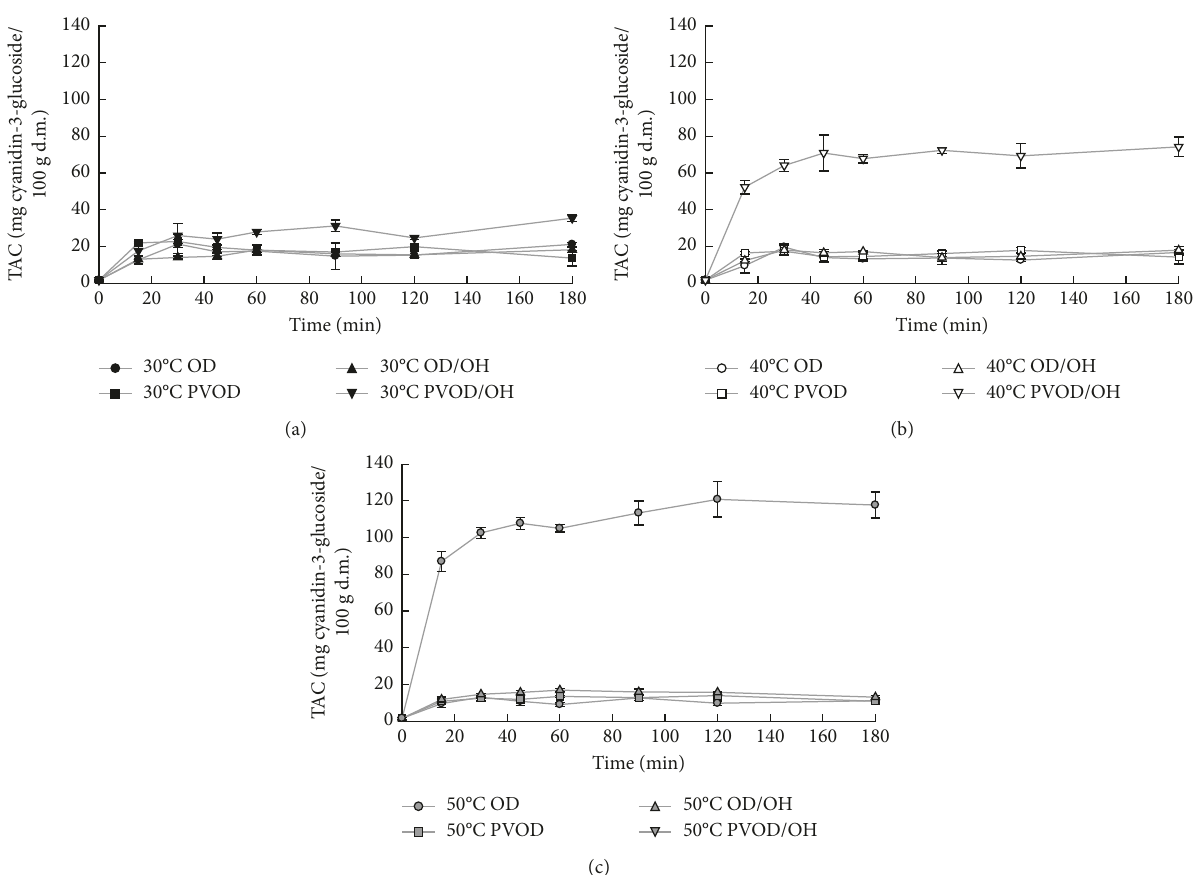
Figure 3: Total anthocyanin content (TAC) kinetics of osmodehydrated apple using cryoconcentrated pomegranate juice (47 ° Brix) for 180min. OD: osmotic dehydration at atmospheric pressure; PVOD: osmotic dehydration with pulsed vacuum; OH: ohmic heating (OD/OH and PVOD/OH) at 6.66V/cm. (a) 30 ° C; (b) 40 ° C; (c) 50 °